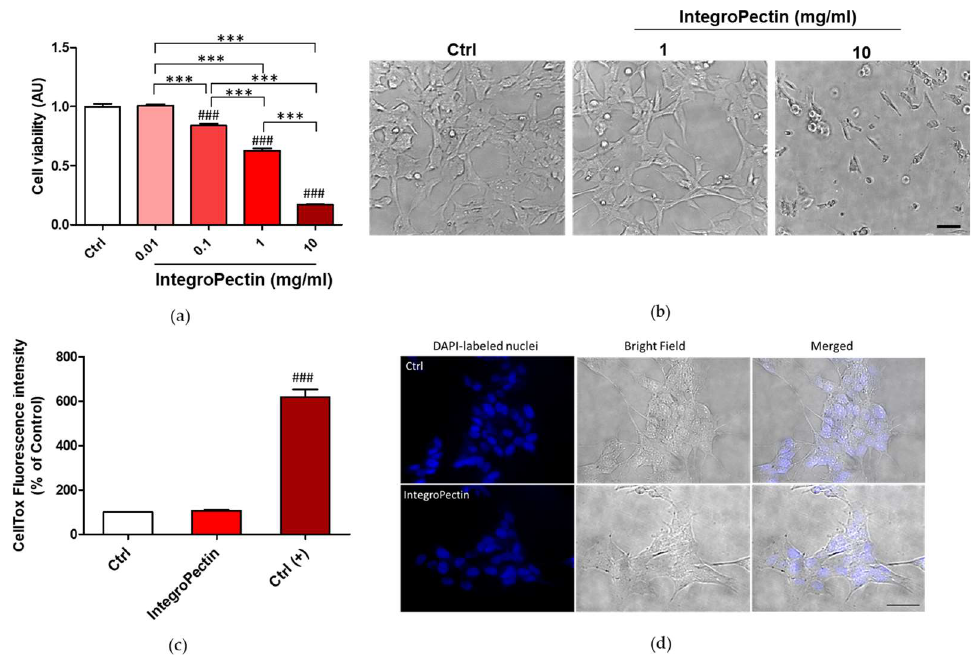
Figure 1. Dose dependent effects of grapefruit IntegroPectin on neuronal cell viability. ( a ) Cell viability of Integropectin treatment (24 h) in dose dependent experiment ( n = 36); ( b ) Representative morphological images of untreated cells (Ctrl) or cells treated with different doses (1, 10 mg/mL) of IntegroPectin (24 h); ( c ) Cytotoxicity associated to IntegroPectin treatment (1 mg/mL, 24 h), evaluated by fluorescence developed using CellTox Green Cytotoxicity Assay ( n = 13). Positive control Ctrl (+) is represented by cell exposure to lysis buffer; ( d ) Microscopy inspection of DAPI-labeled nuclei in Ctrl cells or treated with IntegroPectin (1 mg/mL, 24 h). Related bright field and merged pictures are also shown. Tukey test: ### p < 0.001 as compared to control (Ctrl) group; *** p < 0.001. Scale bar 50 µm.